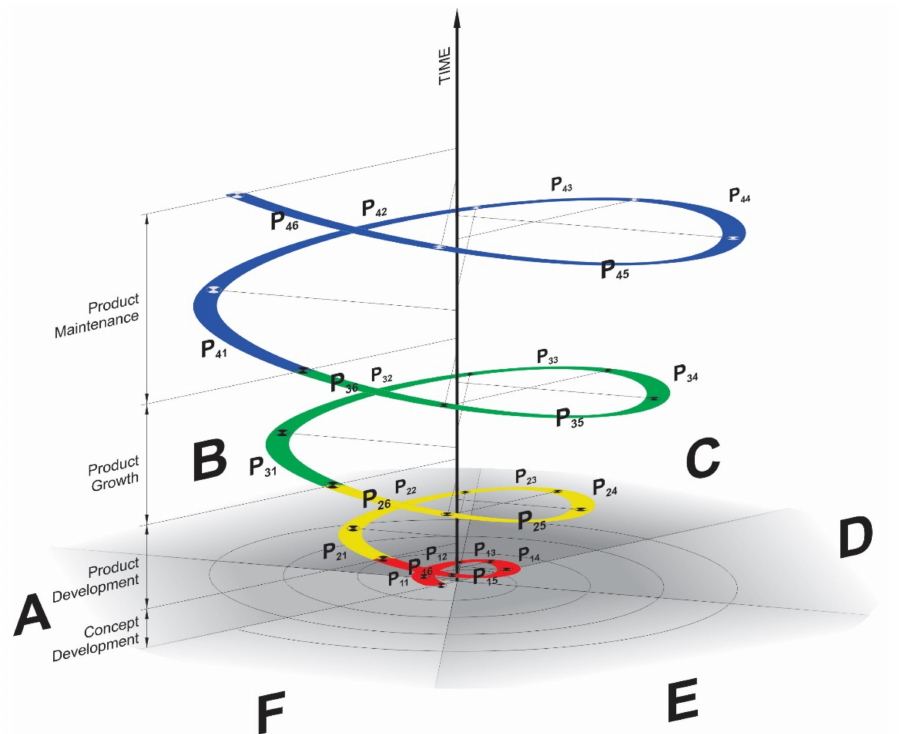
Figure 2. Characteristic six basic phase steps ( A – F ) and levels (I to IV) of the CBCPM, ( A )—communication with potential users, ( B )—planning, ( C )—risk analysis, ( D )—design, ( E )—transfer to practice, ( F )–evaluation, I—concept development project, II—new product